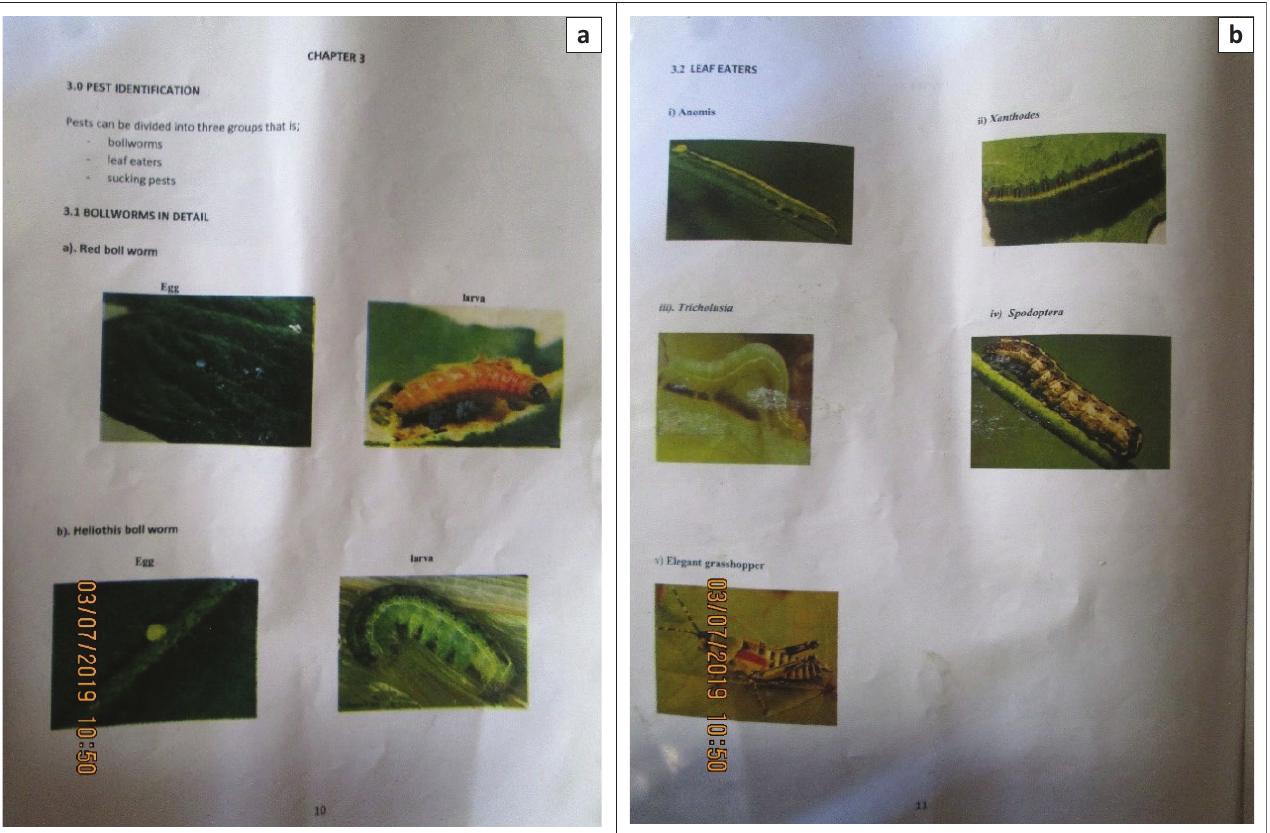
FIGURE 6: (a and b) Extracts from the headman’s manual for cotton